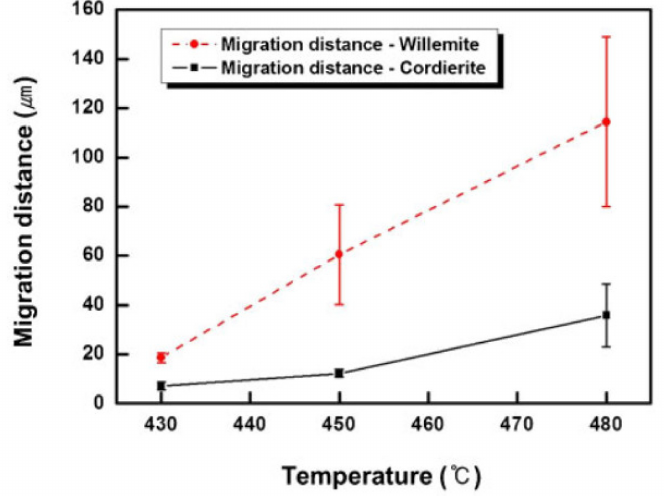
Figure 15. Migration distance of filler particles (cordierite, willemite, 10 vol. %, 11 µ m) into the glass matrix upon sintering at 480 ◦ C for 60 min at a heating rate of 10 ◦ C min − 1 (used with copyright permission) [94].